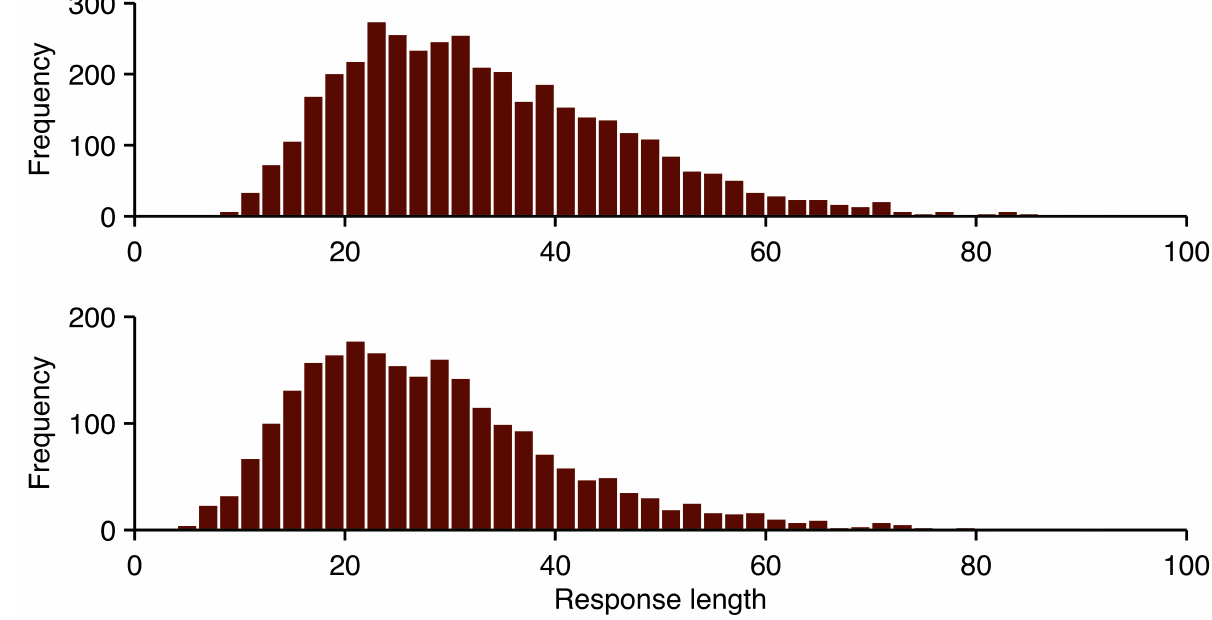
Figure 2. Distribution of number of words in responses in crowdsourced data (top) and lab-sourced data (bottom), after removal of